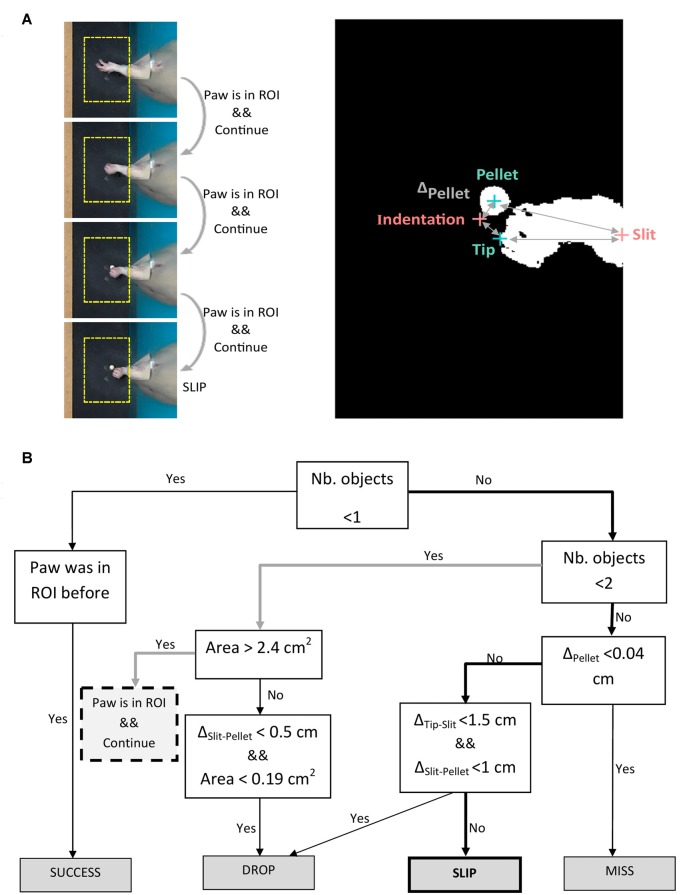
Algorithm for outcome labeling. (A) Left panel: example of algorithm decision on four frames succeeding maximum forepaw extension. Right panel: binary image of the frame in which the slip occurs, showing detected objects (forepaw tip, pellet) and fixed landmarks (indentation, slit). (B) Decision tree algorithm iterated on the frames succeeding maximum forepaw extension. Description of abbreviations: ΔPellet = distance between indentation and current pellet position; ΔTip-Slit = distance between forepaw tip and slit; ΔSlit-Pellet = distance between pellet and slit.